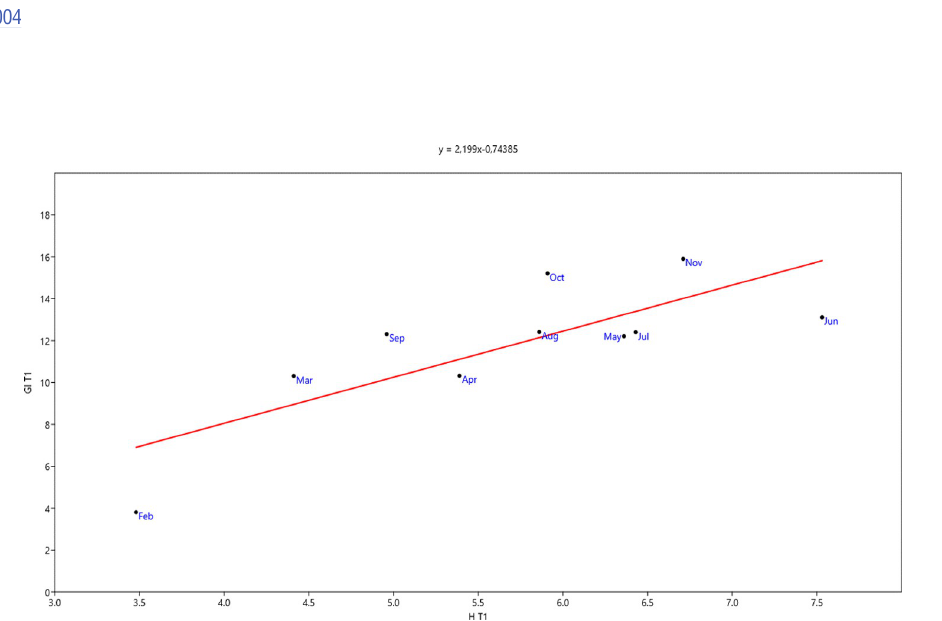
Fig 5. Relationship between growth index and plant height in Sedum mixture.